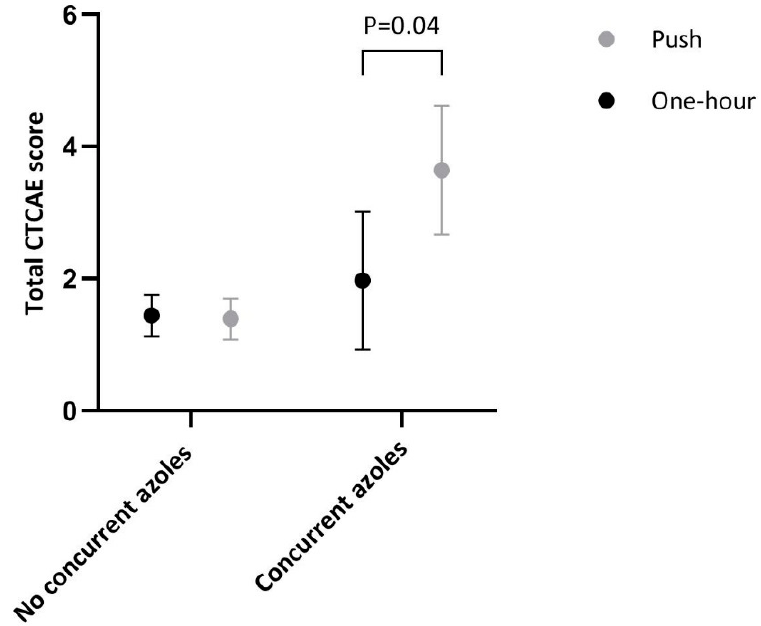
Figure 3. Total Common Terminology Criteria of Adverse Events score per randomization method and taking concurrent azole antifungal treatment into account. CTCAE: Common Terminology Criteria of Adverse Events, dots represent the estimated values and lines of the 95% confidence interval of this estimate. Numbers per group: no concurrent azoles: push group: n = 36, one-hour group: n = 40; concurrent azoles: push group: n = 9, one-hour group: n = 10.